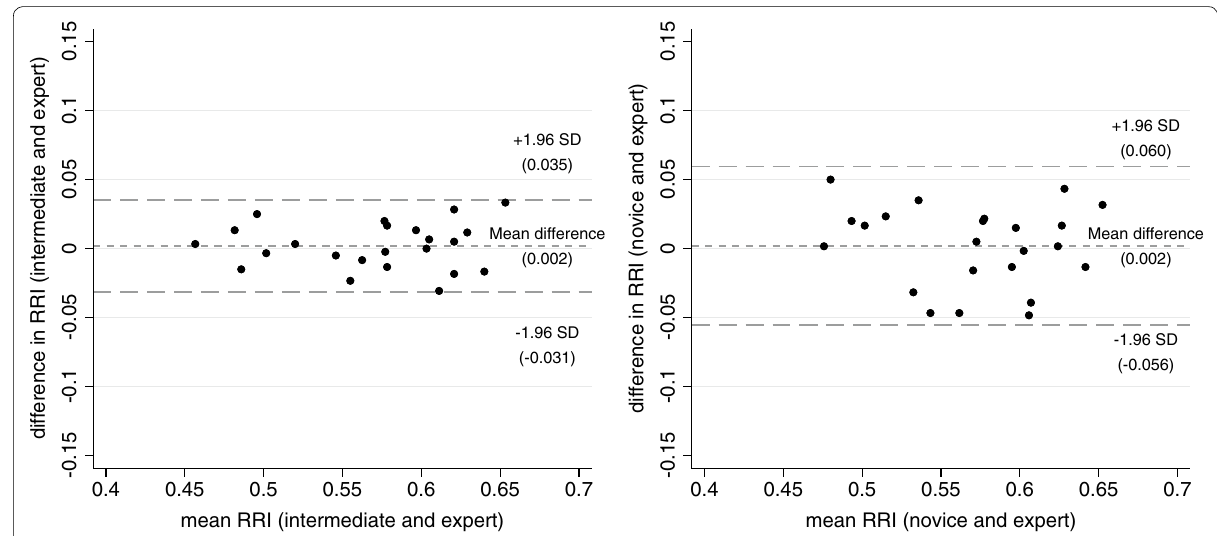
RRI renal resistive index, n number, ICC intraclass correlation coefficient, CI confidence interval, LoA 95% limits of agreement, INT:EXP comparison of intermediate and expert examiners, NOV:EXP comparison of novice and expert examiners